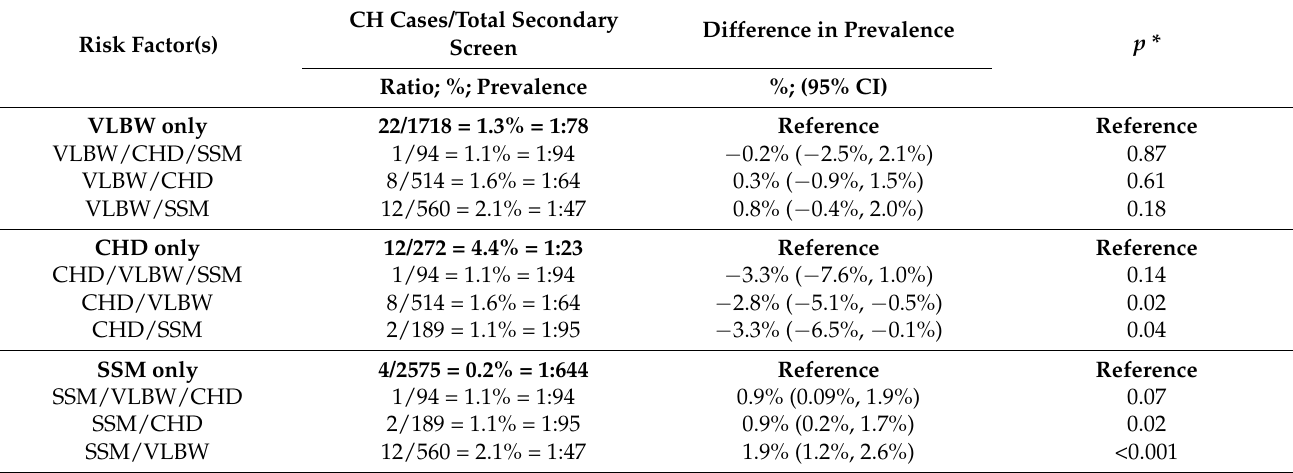
* SSM-only excluded to confirm prevalence of CH is higher when delayed rise in TSH (in CHD and VLBW) is the concern for false-negative primary screen rather than blood admixture in multiples. ** The 1 CH cases in triple-risk group is also counted in each double-risk combination, leading to all the categories showing 2 less CH case than the result obtained by adding the subgroups. *** CHD cases included 8 with endocardial cushion defect, 6 with ventricular septal defect, 2 with atrial septal defect, 2 with both atrial and ventricular septal defects, 2 with complex cyanotic disease, and 1 with aortic stenosis. Table 4. Comparison of prevalence of CH diagnosed on secondary screen in those with individual vs. multiple high- risk